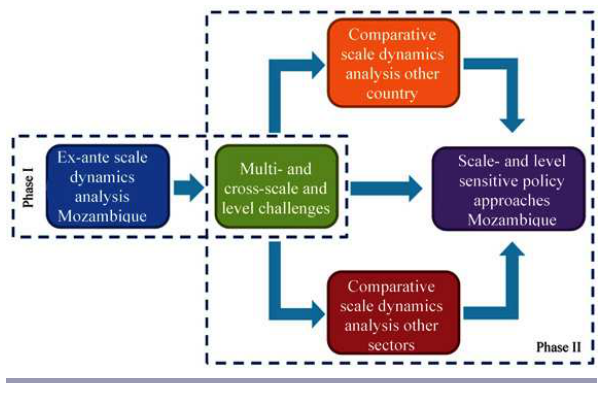
Fig. 3. Schematic representation of scale dynamics analysis: Step 1, Phase I.